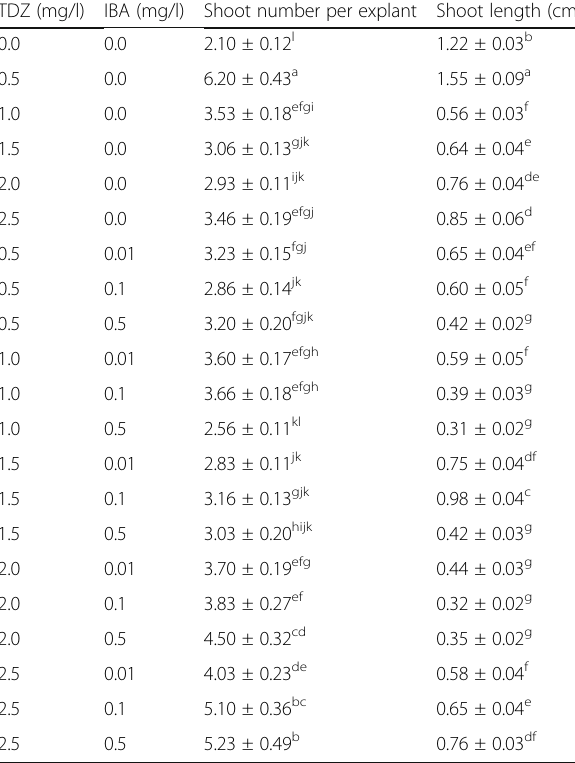
Table 5 Effect of different concentrations of TDZ and IBA on shoot multiplication (shoot number and length) of S. longipedunculata